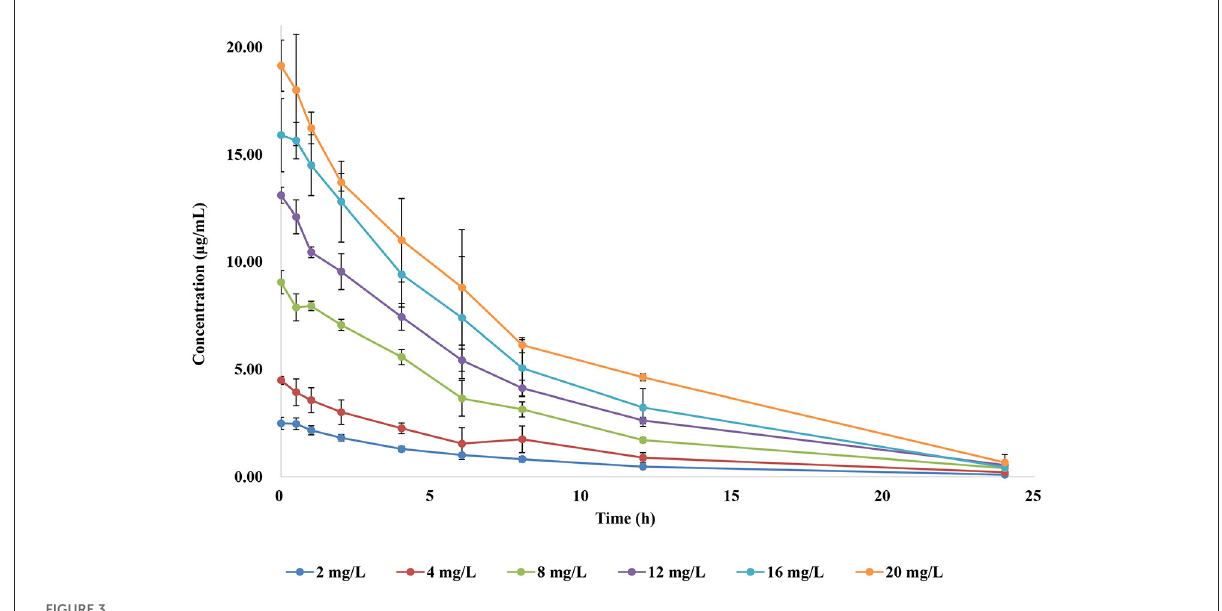
FIGURE3 Concentration–time curves of florfenicol in the dynamic model.